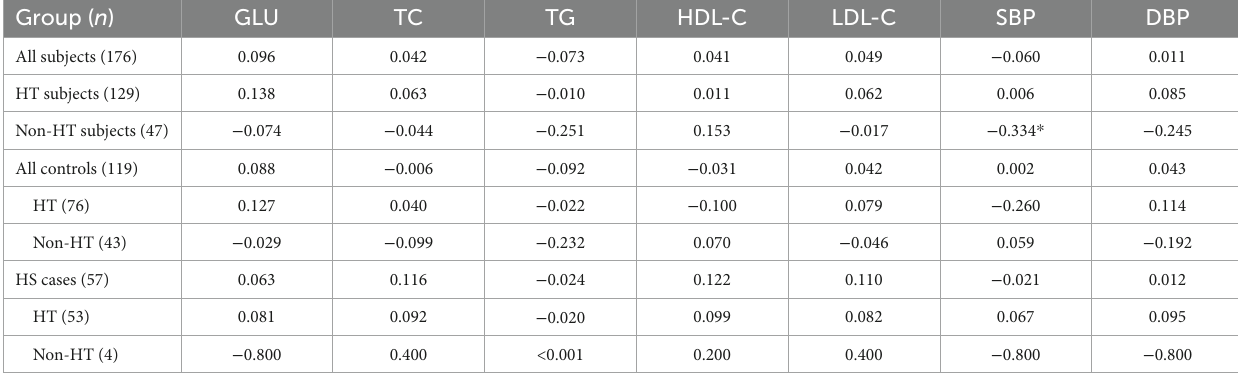
TABLE 6 Correlation analyses between THSD1 mRNA expression (2 −ΔΔ CT ) and clinical